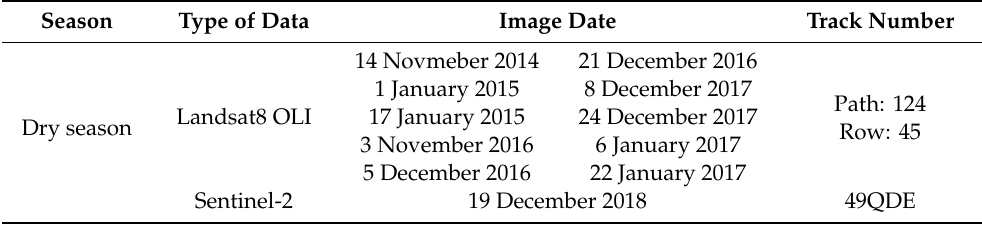
Table 2. Summary of the satellite remote sensing data used in this study, which includes a ground-synchronized remote sensing image on 16 October